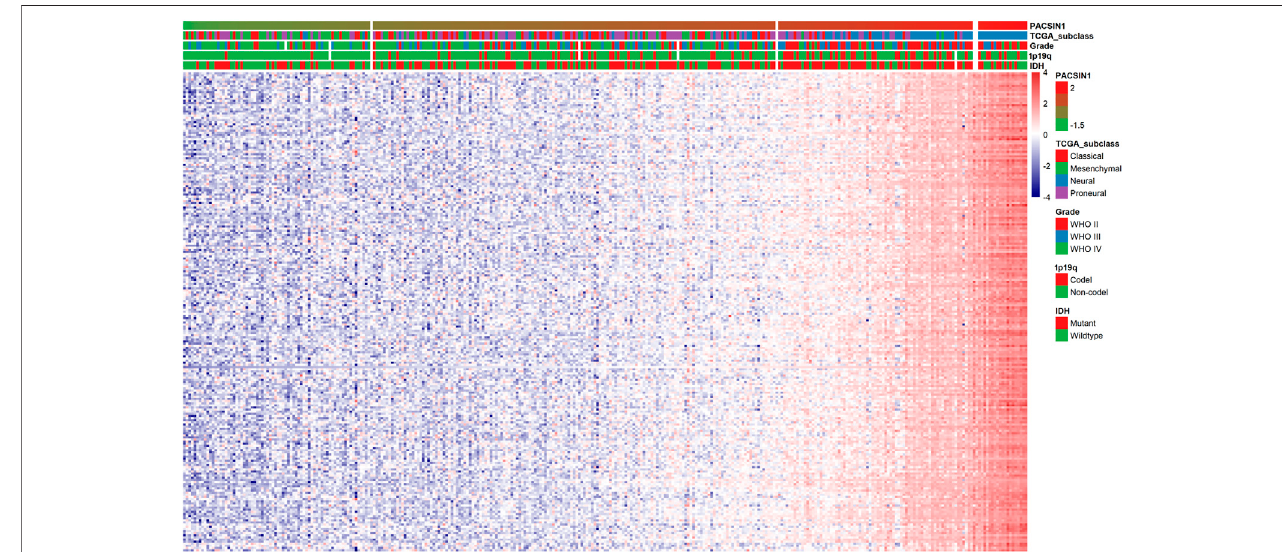
FIGURE 6 | Correlations of 224 DEGs expression with the clinical indicators in gliomas in CGGA dataset.